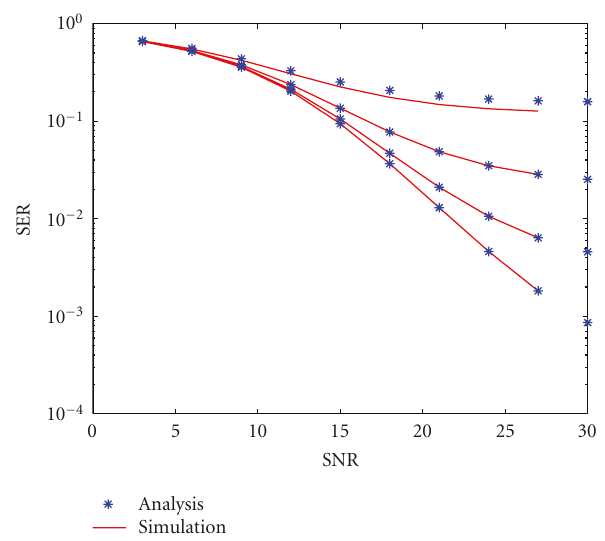
Figure 6: SER versus SNR plots for 16 QAM, with MSE = − 40 dB = (2 π ) 2 / 20000, (2 π ) 2 / 80000, (2 π/ 500) 2 , (graphs are plotted for σ 2 ω (2 π/ 1000) 2 from uppermost to down most,